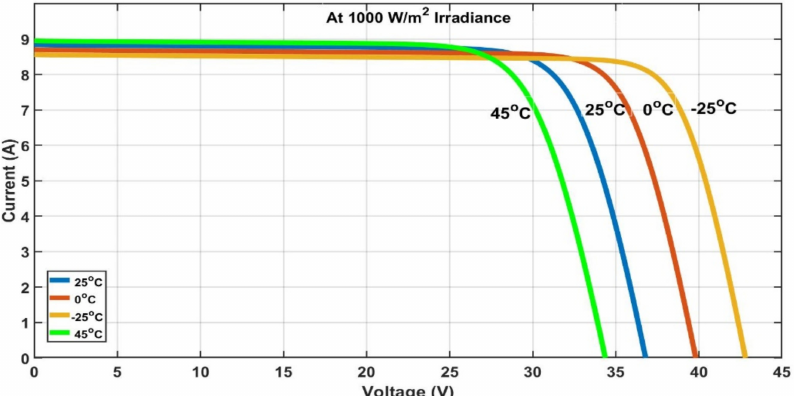
Figure 12. I-V curves with different temperatures at 1000 W/m 2 .